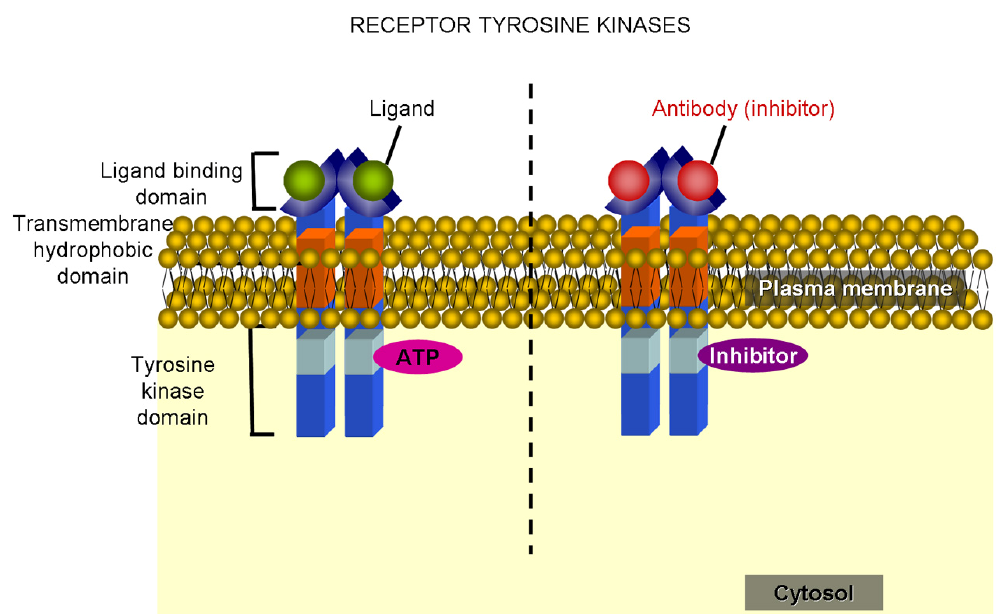
Figure 7. Schematic mechanism for receptor tyrosine kinase inhibition. Antibody- mediated inhibition of the ligand-binding domain and inhibition of the ATP-binding domain are main strategies for receptor tyrosine kinase